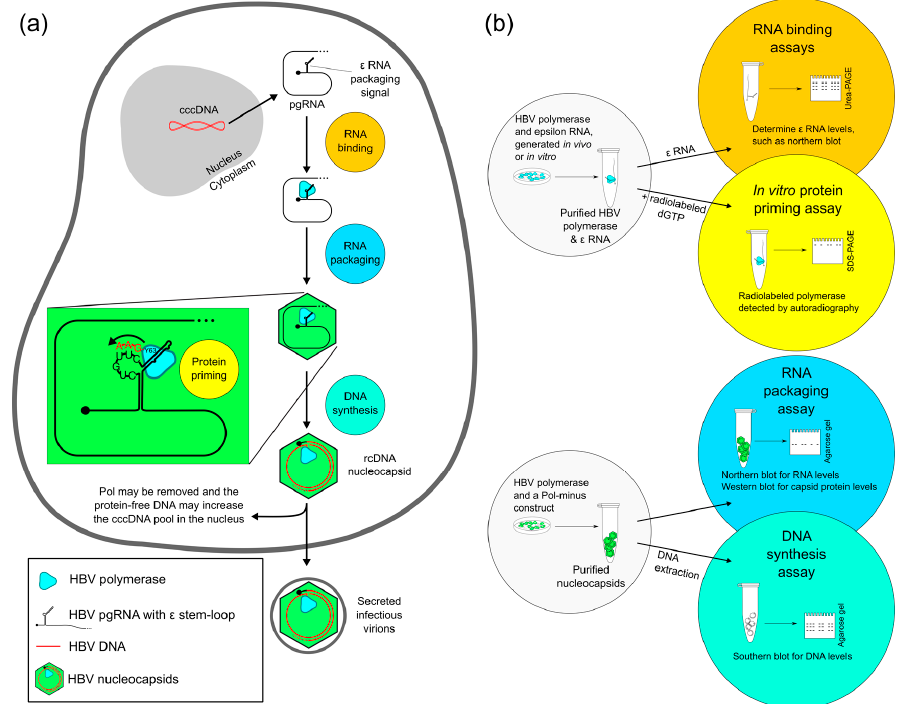
Figure 2. Polymerase-dependent functions of the replication cycle of hepatitis B virus (HBV) and four functional assays of HBV polymerase (HBV Pol) activity. ( a ) Starting with covalently closed circular DNA (cccDNA), which is located inside the nucleus of infected liver cells, the pre-genomic RNA (pgRNA) is transcribed by the host cell. Next, pgRNA is sent to the cytoplasm and translated into viral proteins. The translated HBV Pol binds to pgRNA at the 5 ′ epsilon stem-loop structure. The interaction between the HBV Pol and the pgRNA facilitates the encapsidation (packaging) of the HBV Pol and pgRNA. Priming most likely occurs after RNA packaging, within the nucleocapsid. Using a free hydroxyl group of the tyrosine at position 63 (Y63), HBV Pol performs the dual functions of primer and polymerase. The DNA strand remains attached to HBV Pol while synthesizing the initial GAA nucleotides. HBV Pol and these bases then change templates to the 3 ′ end of pgRNA and carry on minus-strand DNA synthesis. As the template pgRNA is copied, it is degraded by the RNase H activity of HBV Pol. This ssDNA-containing nucleocapsid will mature as the second strand of DNA is copied by HBV Pol, forming relaxed circular DNA (rcDNA). This rcDNA-containing nucleocapsid is the infective particle. ( b ) In RNA binding assays, the HBV Pol can be purified with in vitro synthesized RNA or epsilon RNA from cell culture (referred to as in vivo), which is co-purified with HBV Pol. Together, they can be evaluated for RNA binding activity by measuring RNA levels. Priming is measured from polymerase-epsilon constructs that synthesize DNA in the in vitro priming assay. Due to protein priming, HBV Pol becomes covalently labeled with the radionucleotides and can be detected by autoradiography. RNA packaging assays use HBV Pol and a polymerase-minus construct. The RNA in the purified nucleocapsid is compared to capsid protein levels, a ratio that describes RNA packaging levels. DNA synthesis can also be measured from purified nucleocapsids using HBV-specific Southern blotting. ε : epsilon RNA secondary structure motif.